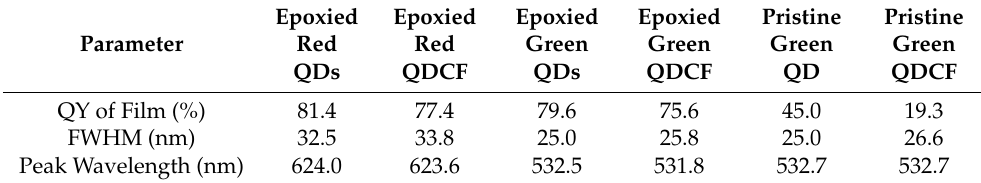
Table 1. Optical performance of QDs and